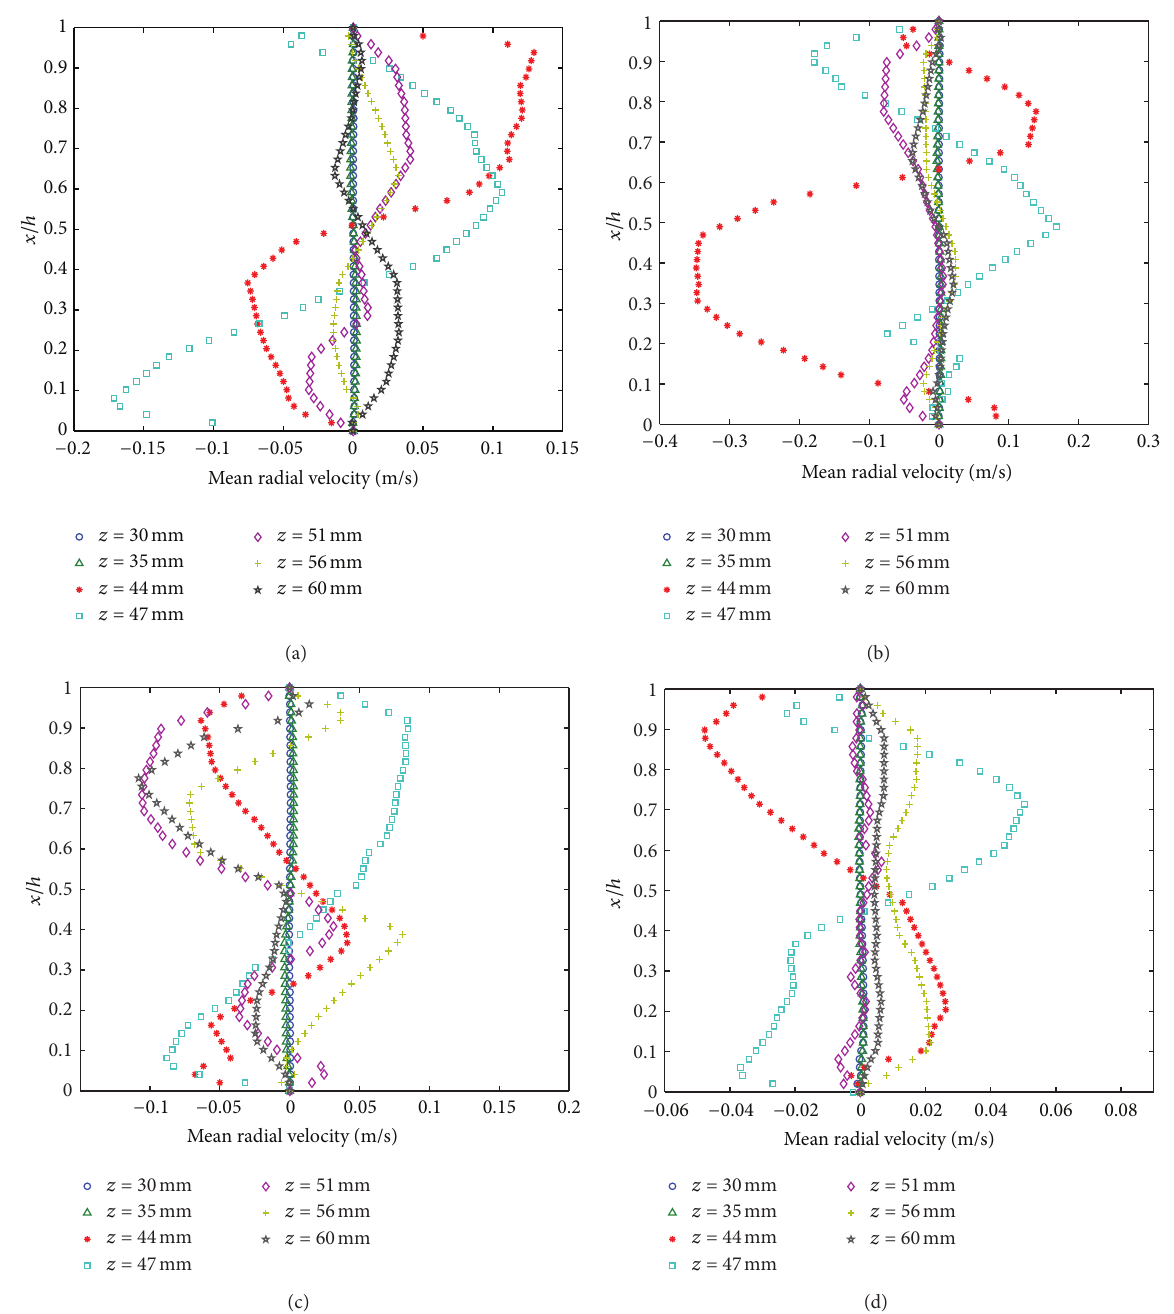
Figure 7: Radial mean velocity profiles plotted against wall-normal distance scaled by lumen height ( ℎ ) at different axial positions along the length of the artery during peak systole ( 𝑄 max ) for (a) Type I, (b) Type II, (c) Type III, and (d) Type